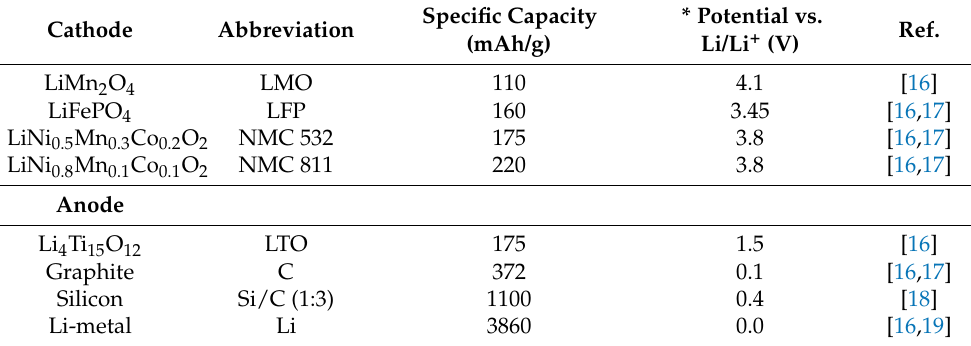
Table 1. Specific properties of the most common anode and cathode materials in